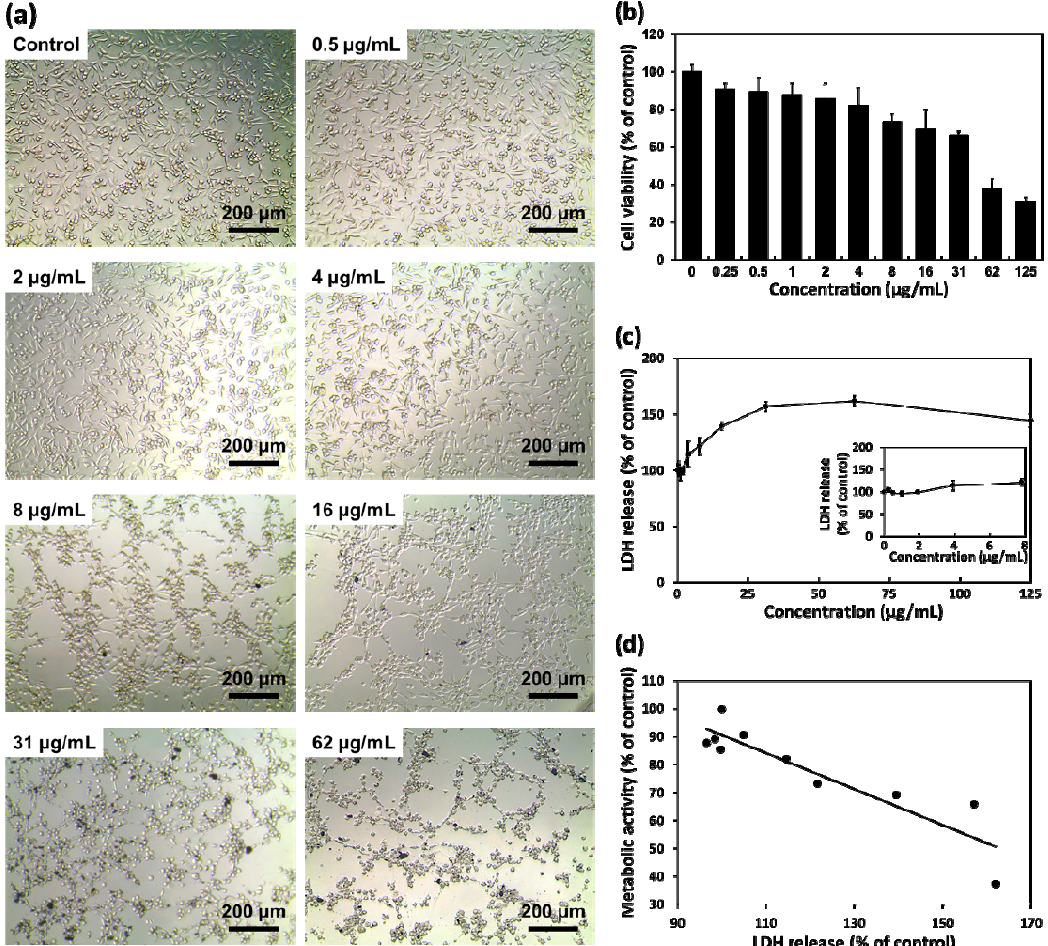
Figure 2. ( a ) Representative optical microscopy images of L-929 fibroblasts cultured with layered BP (0, 0.5, 2, 4, 8, 16, 31 and 62 μ g/mL). ( b ) Cell viability and ( c ) LDH release profile of L-929 fibroblasts after 24 h of incubation with various concentrations of layered BP. ( d ) Correlation coefficient plot between metabolic activity and LDH release for cells cultured with layered BP at concentrations ranging from 0 to 62 μ g/mL.